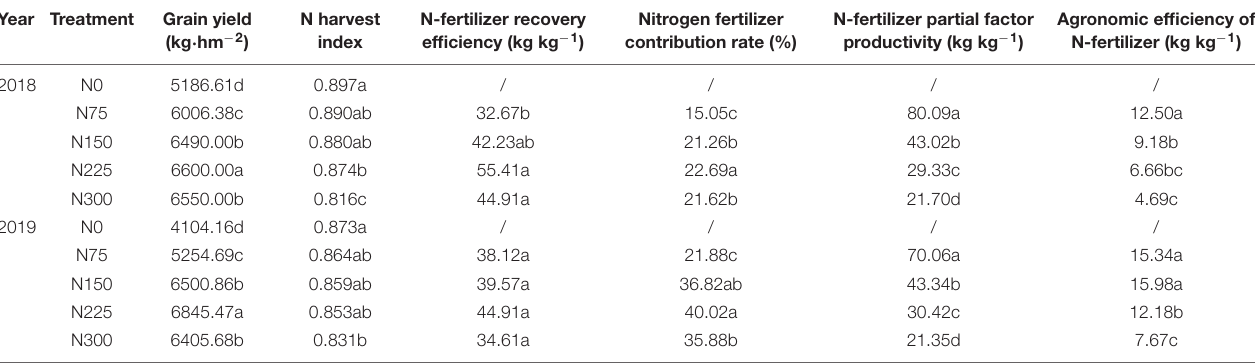
TABLE 5 | Effect of nitrogen (N) application rates on grain yield, N fertilizer recovery, N fertilizer contribution efficiency, N fertilizer partial factor productivity and agronomic efficiency of N fertilizer in winter wheat during 2018 and 2019. Year